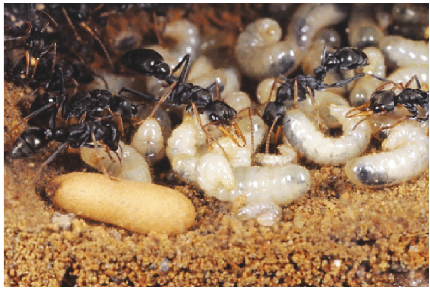
Figure 1: Myrmecia impaternata , queen, workers, larvae, and a pupal cocoon in a laboratory observation nest (RWT,